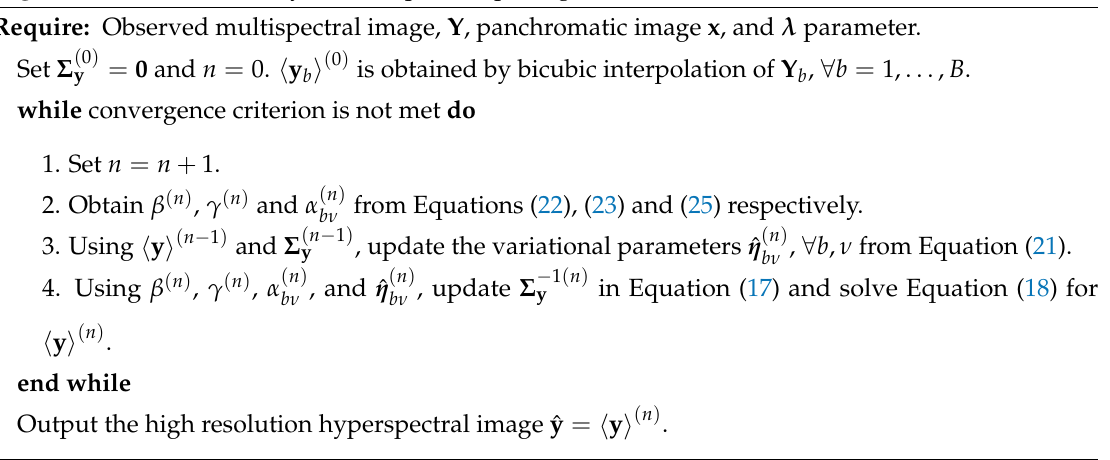
Algorithm 1 Variational Bayesian SG pansharpening.